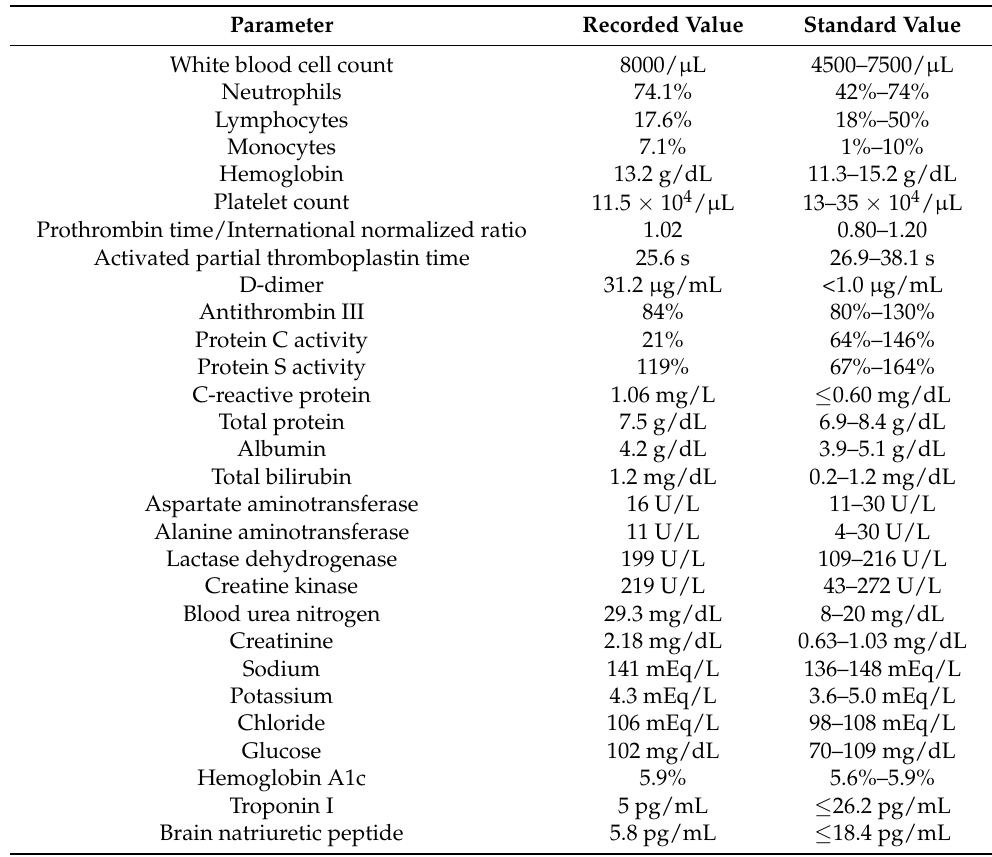
Table 1. Laboratory data upon